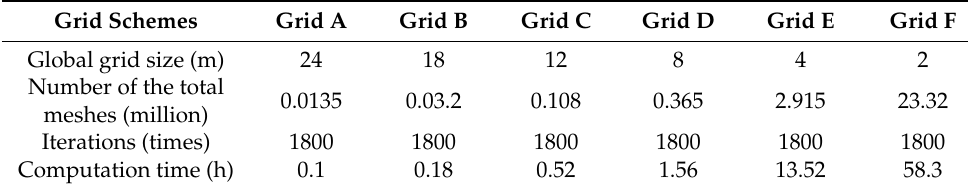
Table 3. The computation time of different grid schemes for GH_Wind.